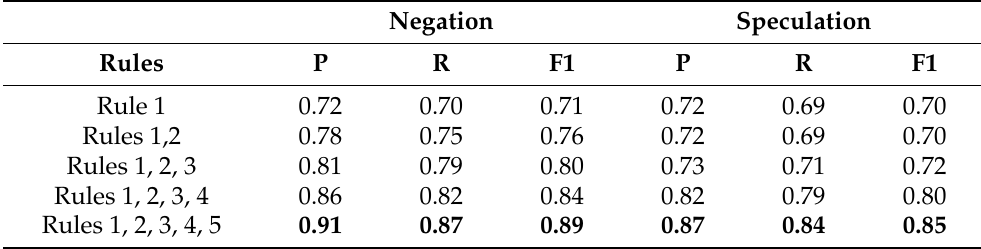
Table 5. Results for the scope recognition